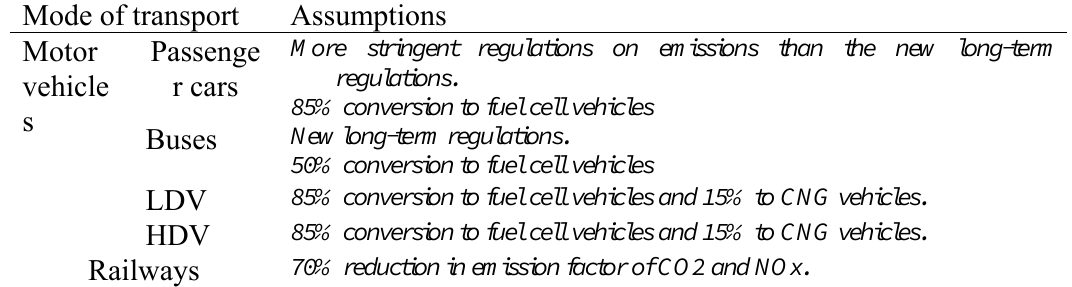
Table 14. Assumptions on technological developments in EST1 Scenario (Aichi Prefecture) Mode of